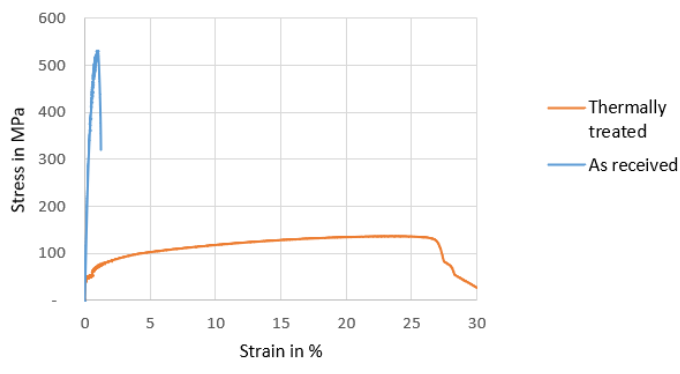
Figure 7. Stress-strain curve for pure Fe. Figure 7. Stress- strain curve for pure Fe. The experimentally determined relaxation curves of the cold-rolled samples with and without hydrogen are shown in Figure Figure 7. Stress- strain curve for pure Fe.